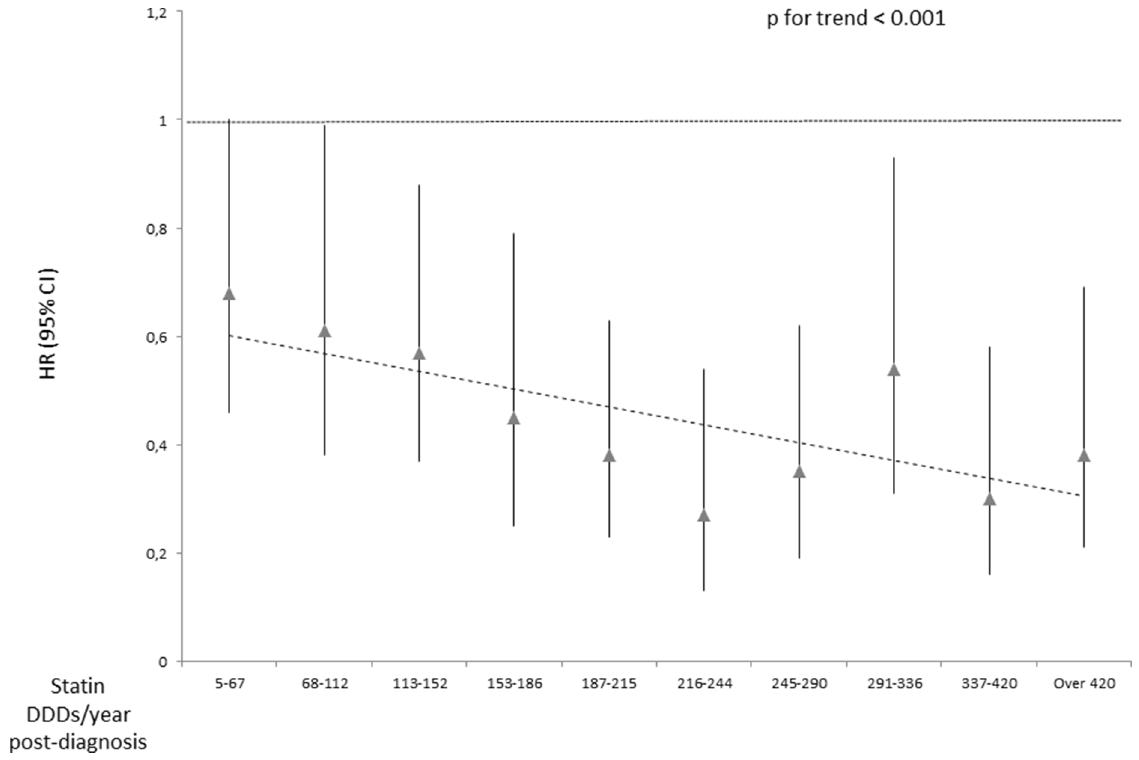
Figure 1. Trend in breast cancer mortality by intensity (doses/year) of post-diagnostic statin use. Nationwide cohort of all female breast cancer patients in Finland during 1995–2003.